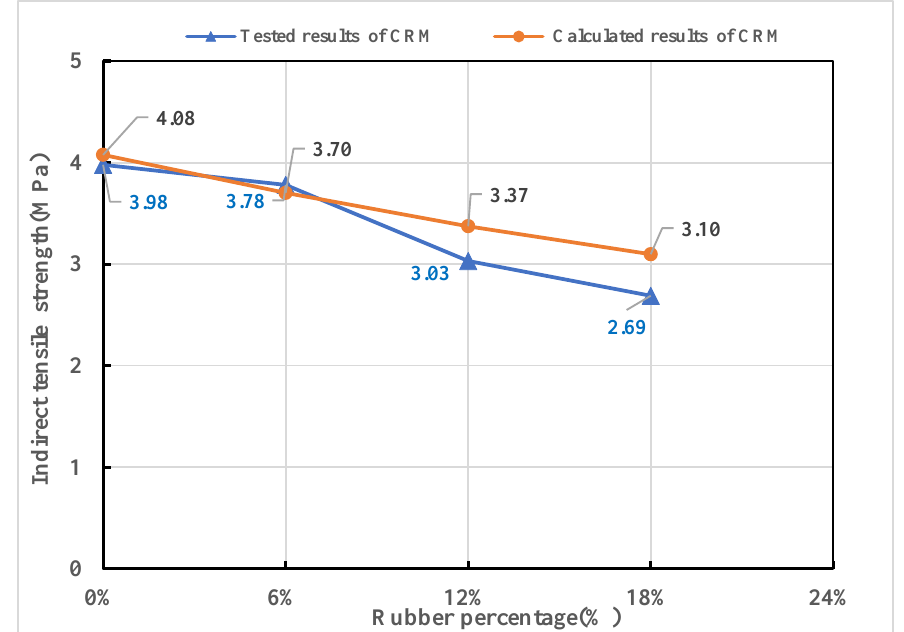
Figure 21. Comparison of results obtained from experiment and mesoscale simulation.